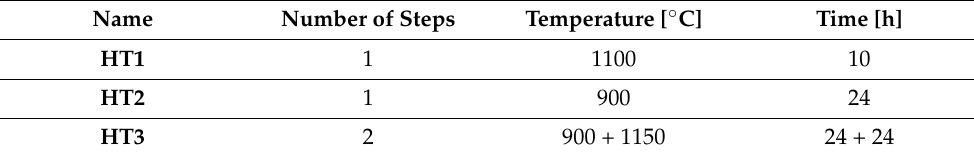
Table 1. Parameters of the heat treatments of in situ alloyed NiTi fabricated by